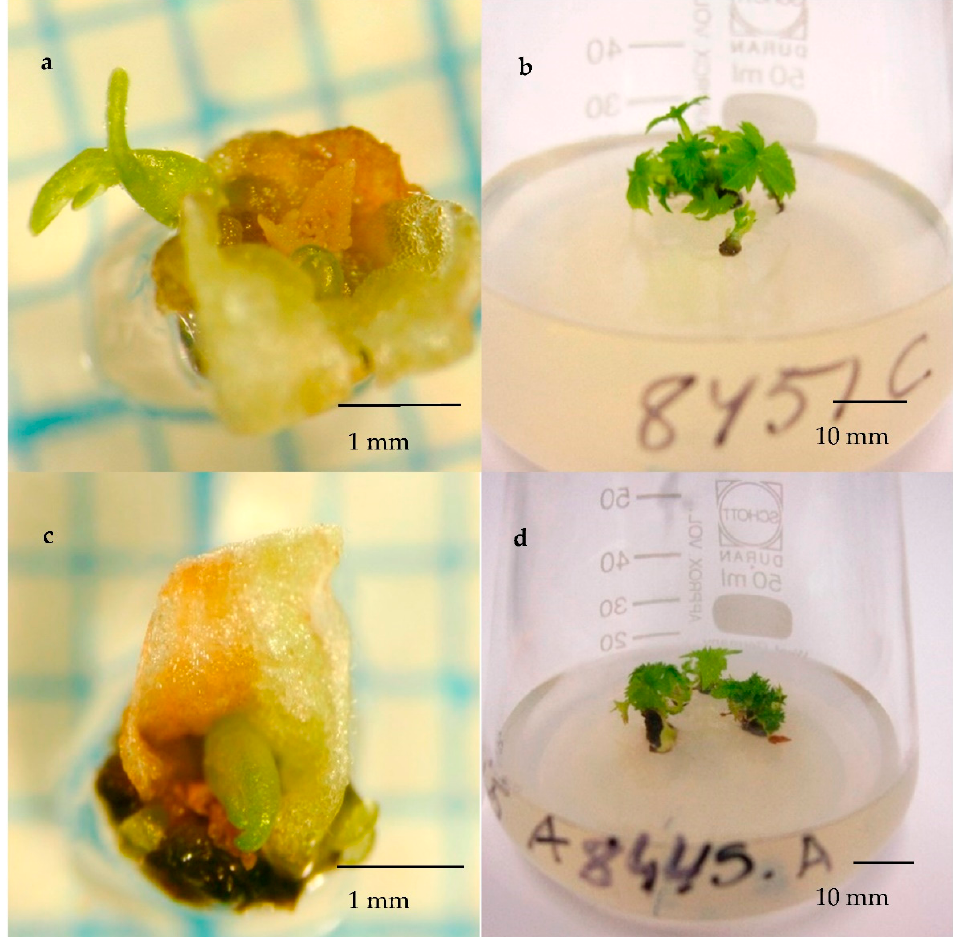
Figure 2. The recovery of cryopreserved buds of cv. Brödtorp in vitro. Top row: the propagule excised from a non ‐ rehy ‐ drated bud ( a ) 2 weeks after initiation of in vitro culture (photo Dr. Mauritz Vestberg) and ( b ) 10 weeks after initiation. Bottom row: the propagule excised from a bud rehydrated 11 days ( c ) 2 weeks after initiation of in vitro culture (photo Dr. Mauritz Vestberg) and ( d ) 10 weeks after initiation. Bud sections of cv. Brödtorp were cryopreserved without pre ‐ desic ‐ cation and revived from cryostorage via fast thawing. Images a and c were taken on graph paper through a stereomicro ‐ scope.